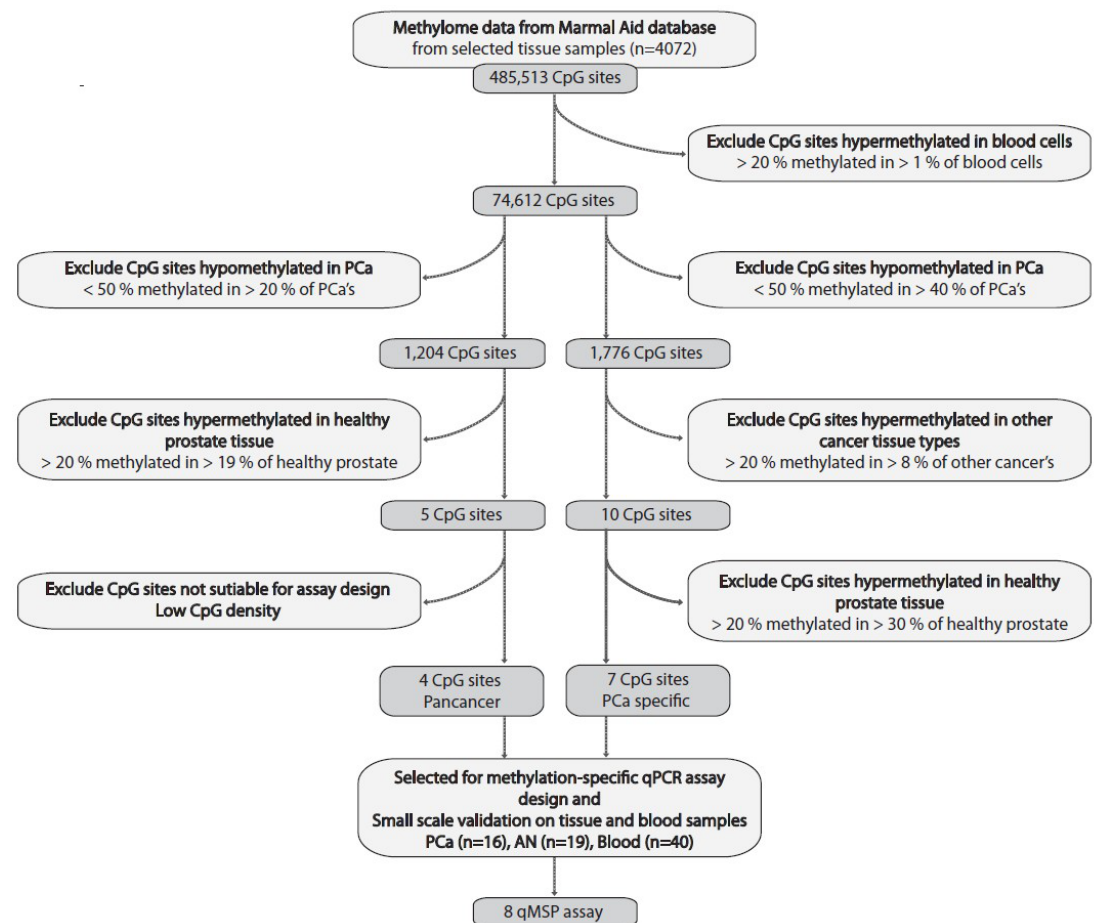
Figure 2. Flow chart of biomarker discovery process using 450K array data from the Marmal-aid